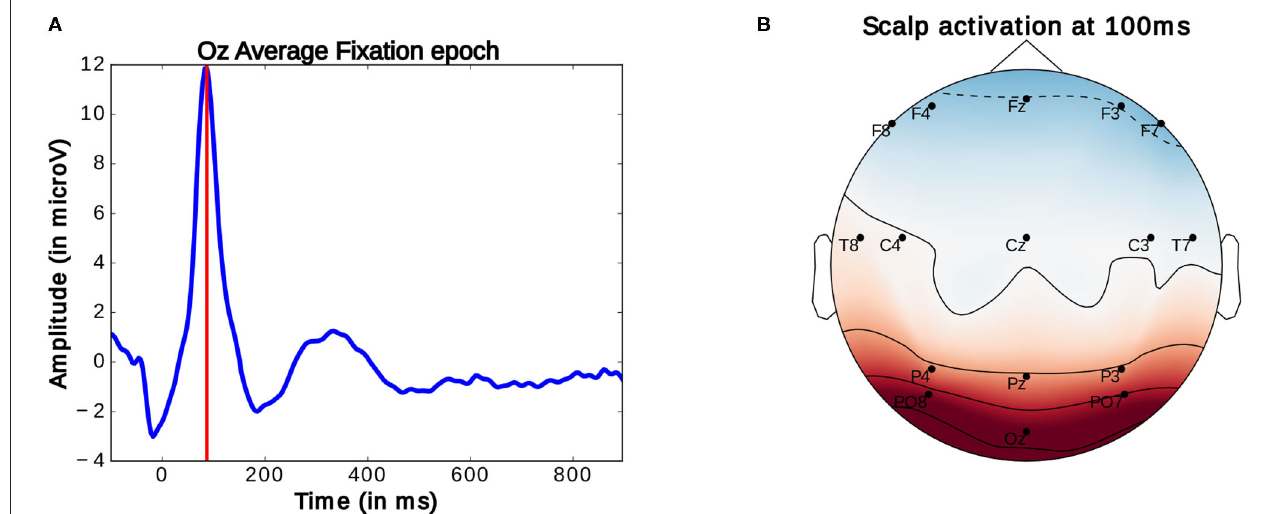
FIGURE 7 | (A) Average Fixation related potential epoch profile recorded on the Oz electrode. The red line marks the location of P100 peak. (B) Scalp activation at the P100 peak. A redder color indicates a higher measure voltage at that location. The bottom central electrode is Oz. Only data from one participant was used in this